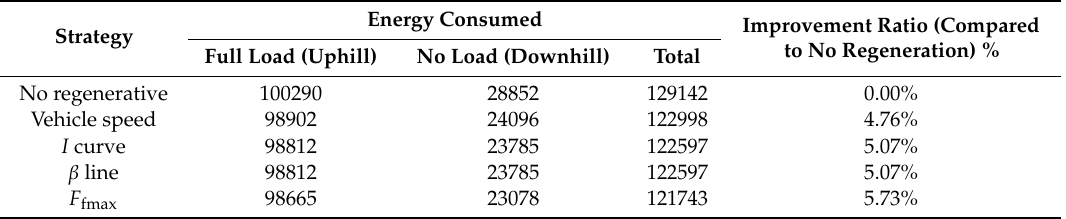
Table 6. Energy consumption of vehicle road drive cycle （ f = 0.02 ） [kJ].